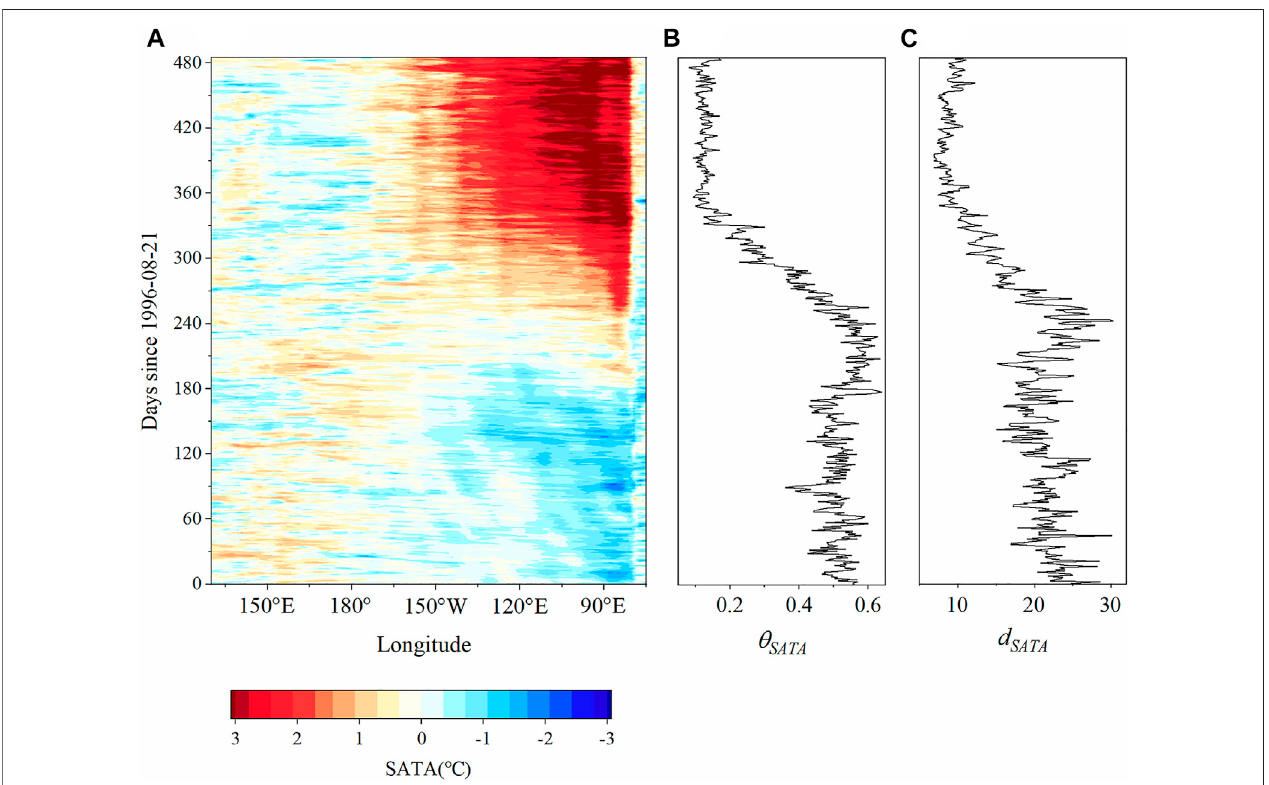
FIGURE 3 | The SATA temporal evolution from 1996-08-21 to 1997-12-09. (A) SATA is averaged over 5 ° S – 5 ° N as a function of time and longitude. (B) and (C) show the time series of θ SATA and d SATA .